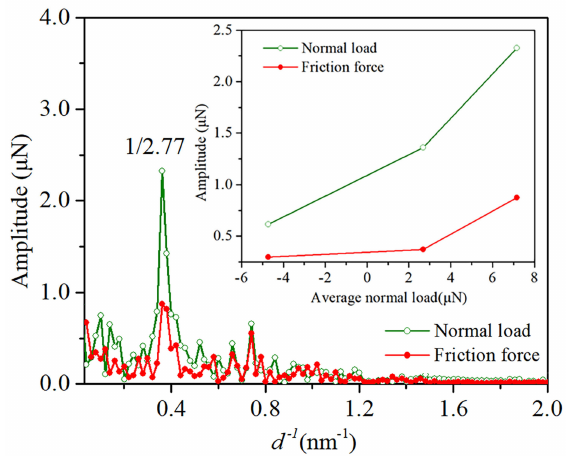
Figure 3. Typical amplitude spectra of the L and f oscillations for the nanopatterned surface with l p = 2.17 nm and λ = 50%. The insert shows the amplitude of the normal load and friction force as a function of the average normal load.